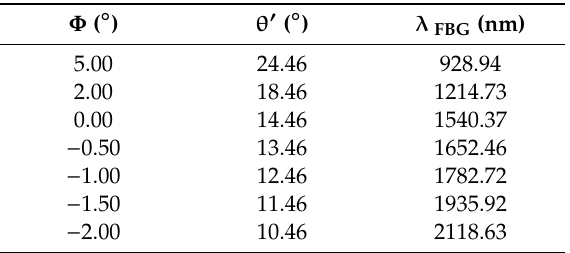
Table 1. Calculated relationship between the rotation angle Φ of the mirror and the interference angle Φ ’, central wavelength of fiber Bragg grating (FBG) Λ FBG ,